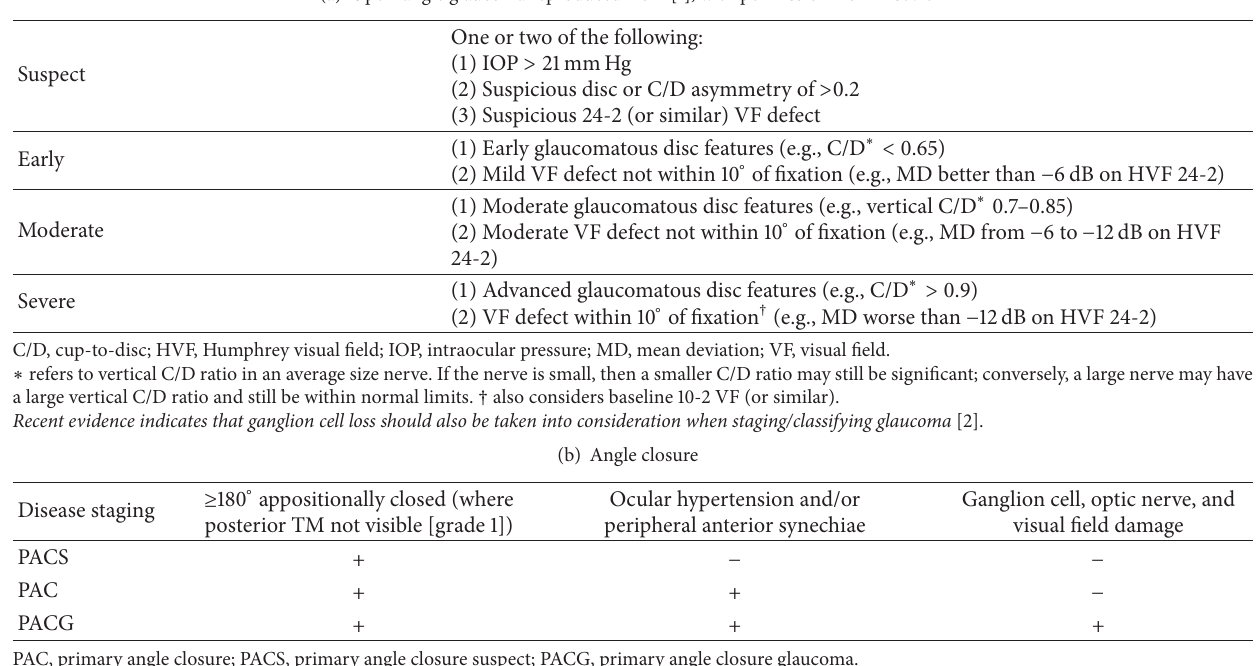
Table 1: Glaucoma classification according to severity of the disease.